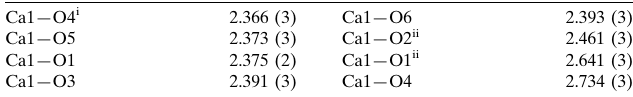
Selected geometric parameters (A˚ , (cid:2) ).